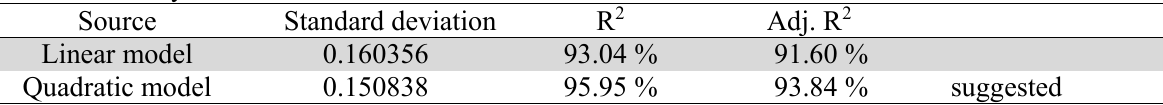
Model summary statistics for